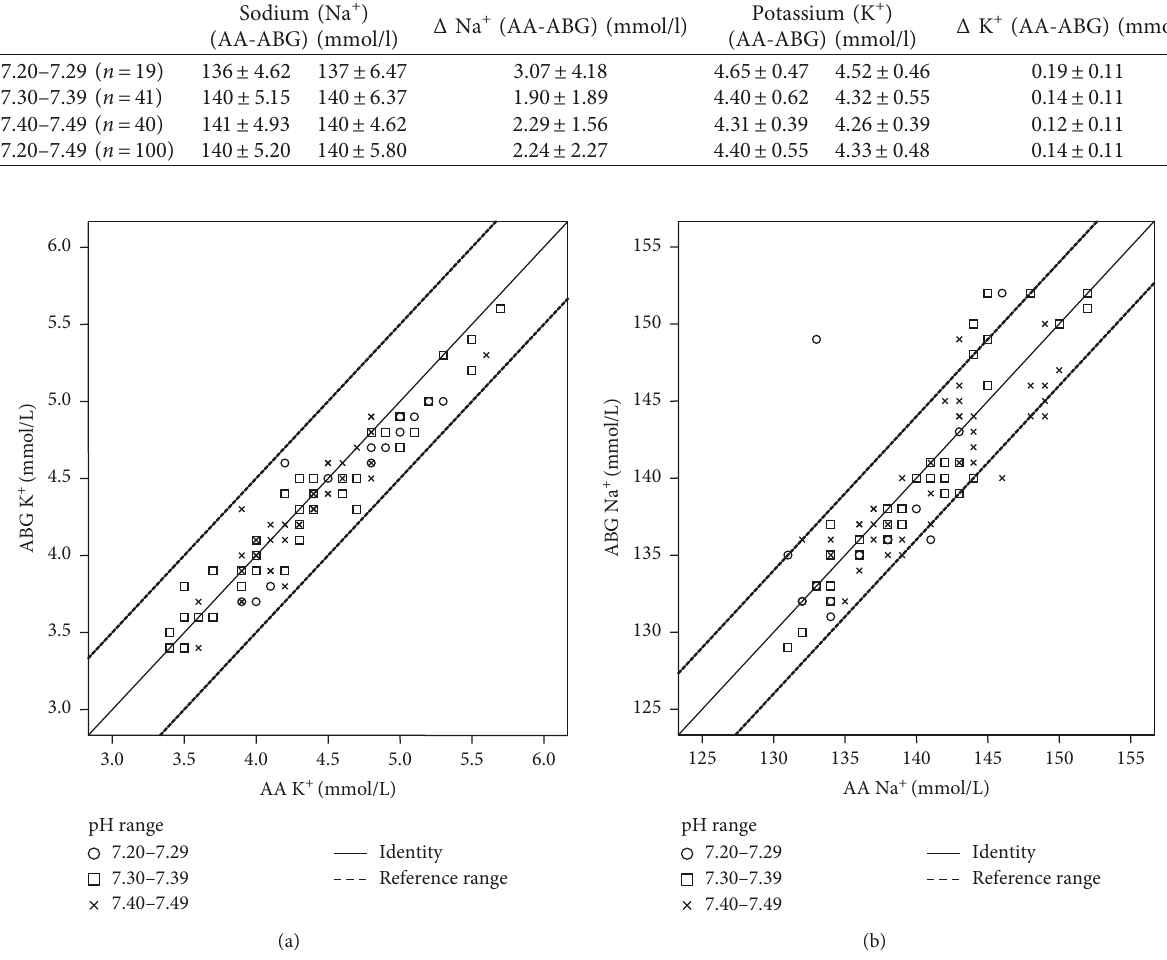
Figure 1: Scatter plots presenting total measurements with ABG and AA for potassium (a) and sodium (b). Deviations in measurements of potassium with AA and ABG were all within the reference range of a maximum difference of 0.5mmol/L overall and separately for distinct pH value ranges (a). For sodium, analysis demonstrated several variations above and below a threshold value of 4.0mmol/L for all pH ranges (b). Solid line: identity between the measuring methods. Dashed lines: maximum tolerated difference according to the US